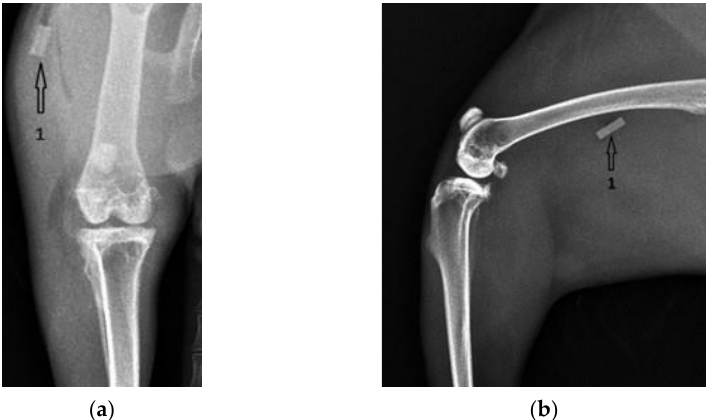
Figure 9. Group two, second day after surgery. 1-The Mg-1Ca implant: ( a ) Coronal view; ( b ) Lateral view.